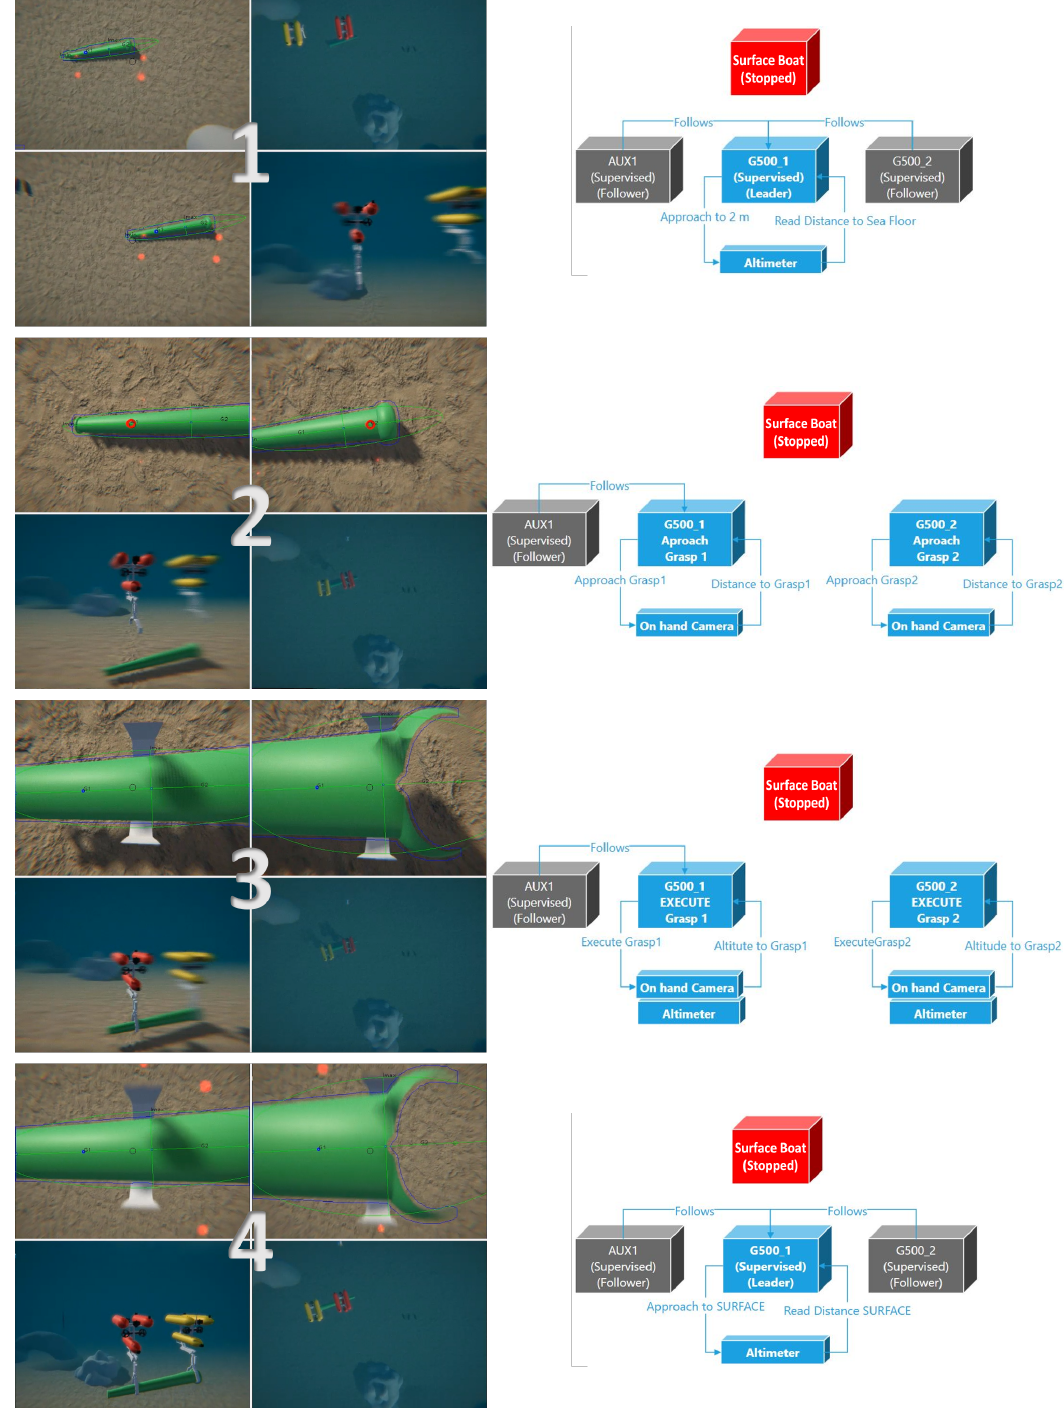
Figure 25. Experiment IV: vision for multi-robot grasping in underwater